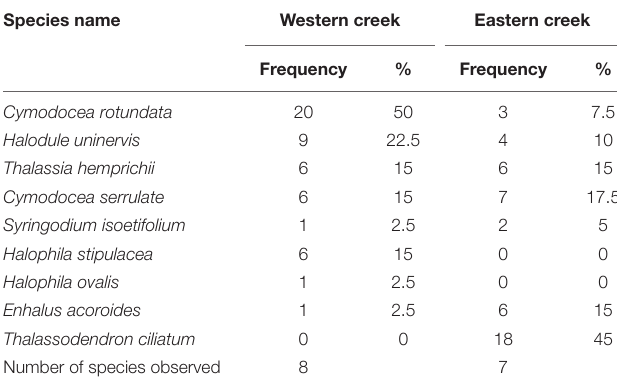
TABLE 2 | Seagrass species distribution and frequency in the Eastern and Western